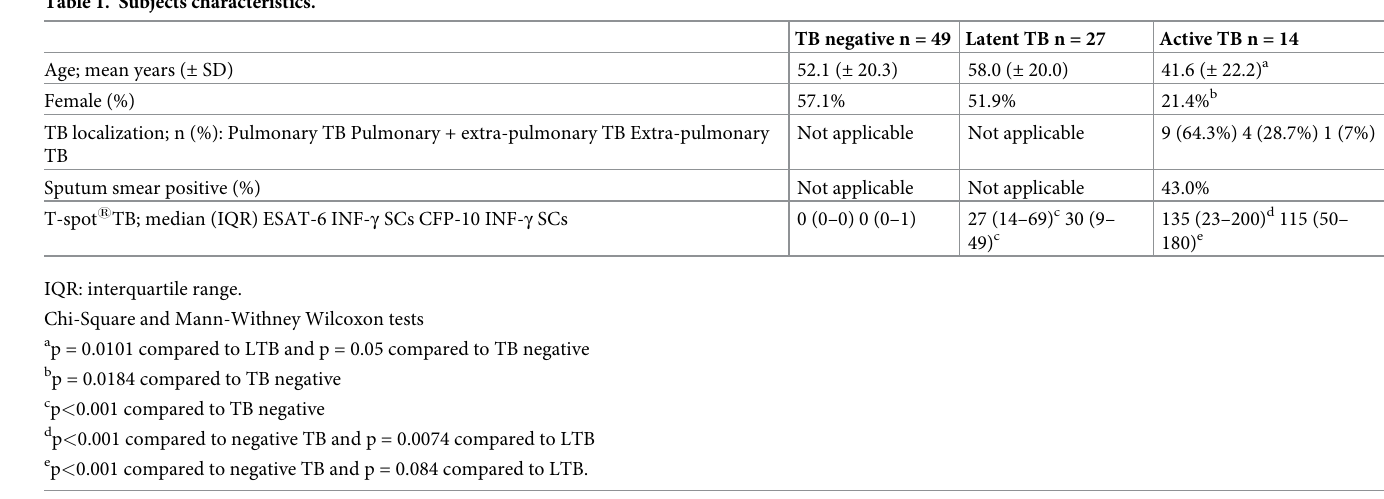
extra-pulmonary localizations and one displayed a strictly gastro-intestinal localization. All active TB cases were confirmed by culture and Mtb specific probe utilization. A therapy against active TB was initiated after sampling for all the patients included in the active TB group.